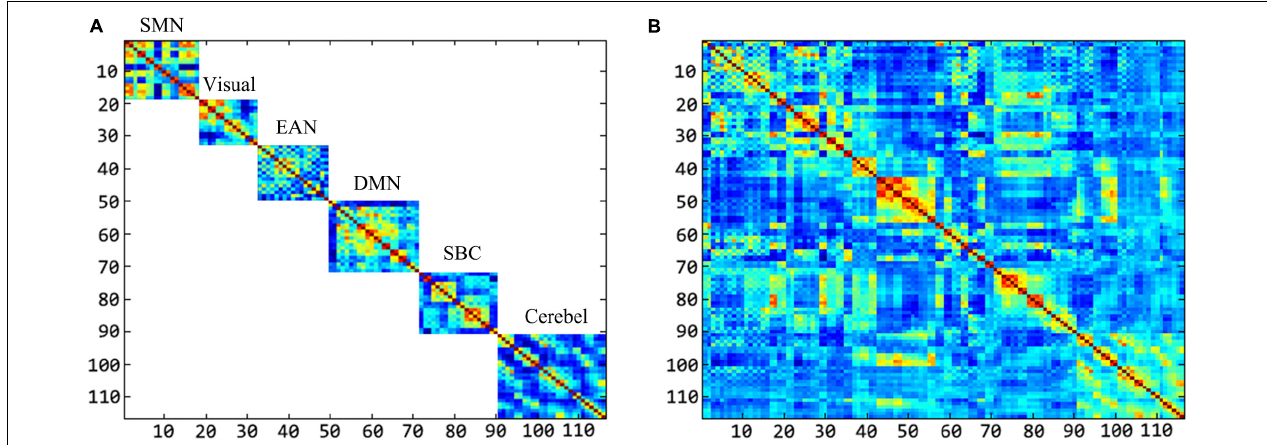
FIGURE 11 | The comparison of the feature dimension in both methods. (A) Shows the feature dimension of each sub-network. (B) Shows the feature dimension of the fully-network.